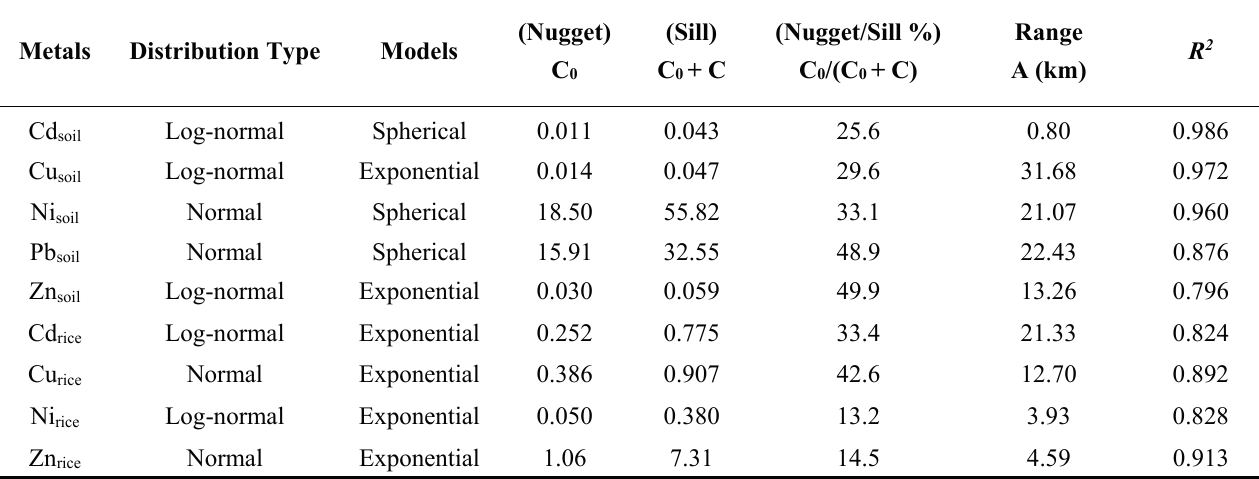
Figure 2. Enrichment index of heavy metal concentrations between soil and rice in paddy field. Different capital letters mean significantly different at the 0.05 level. Table 5. The theoretical semivariogram models and their corresponding parameters for heavy metals in